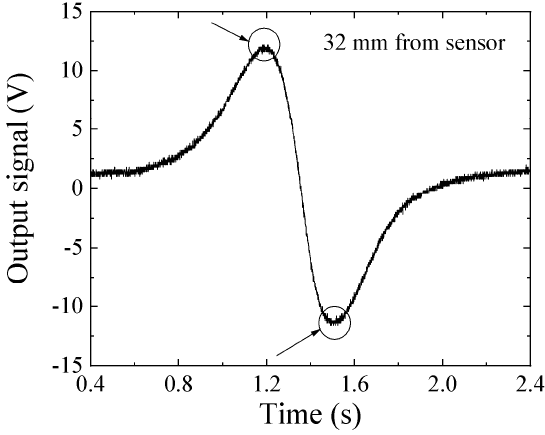
Figure 16. Measured waveform when z = 32 mm.